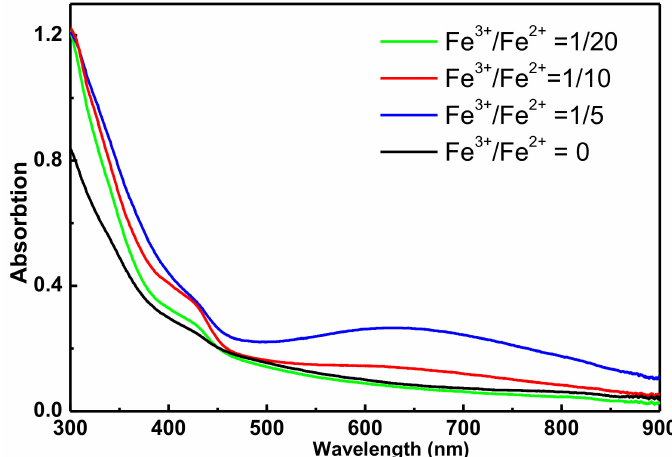
Figure 3. UV–Vis absorption spectra of the methanol solution of nanocapsule after addition various amount of Fe 3+ . The concentration of Fe 2+ is 0.185 mg · mL − 1 .